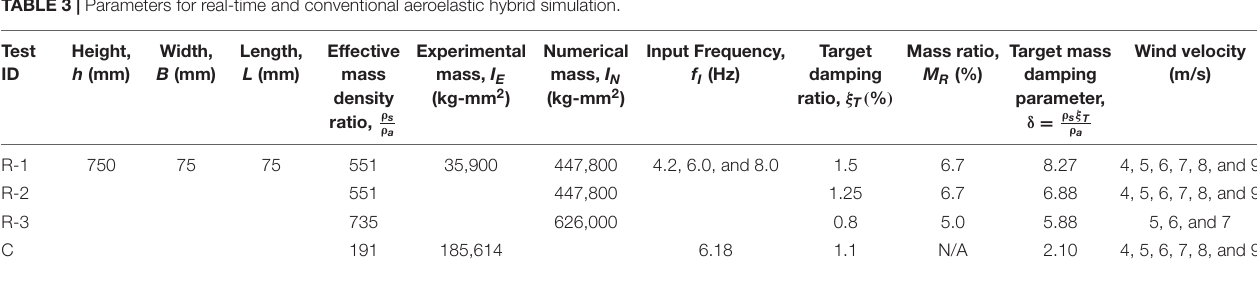
FIGURE 7 | Experimental and calculated damping comparison. (A) Change of damping with mass ratio, (B) comparison of calculated and measured damping. TABLE 3 | Parameters for real-time and conventional aeroelastic hybrid